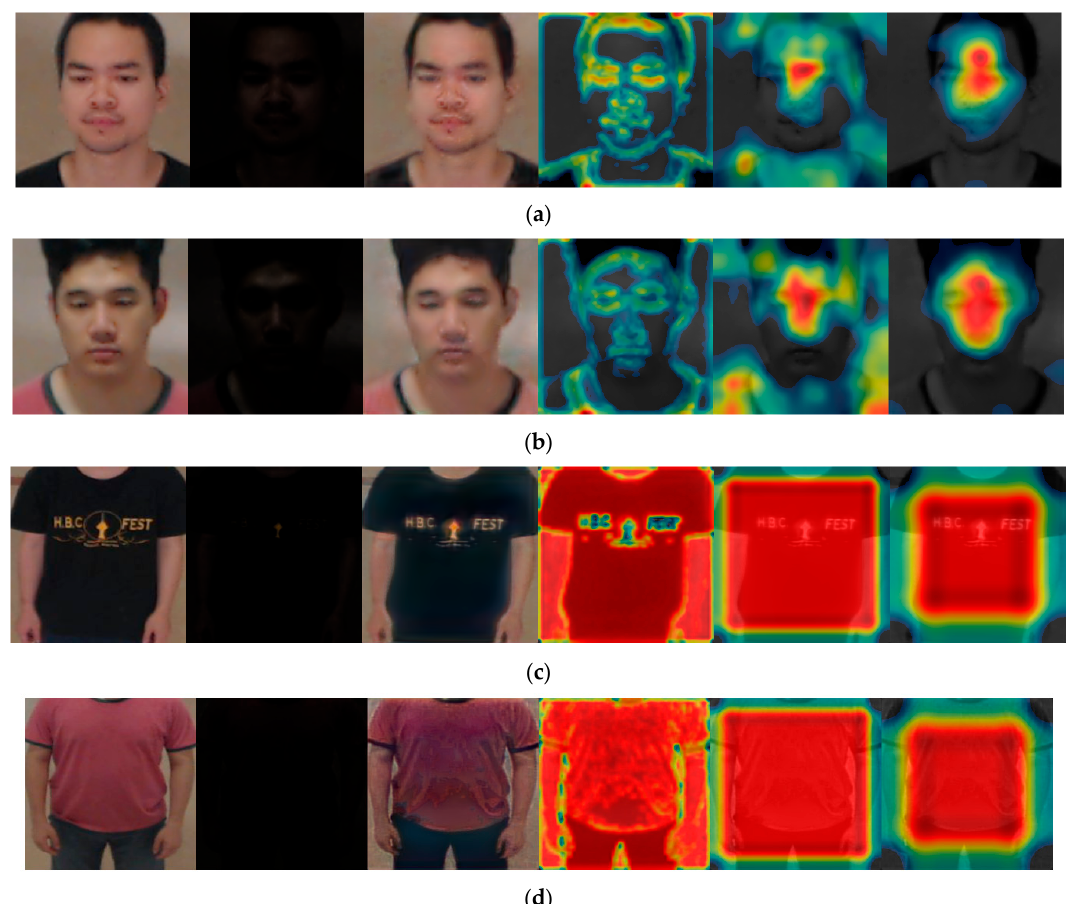
Figure 14. Results on class activation feature map of DFB-DB3. ( a , b ) are the activation map results from face images. From the left image to the right image: original image, low-illumination image, enhancement image from modified EnlightenGAN, result from 7th ReLU layer, result from 12th ReLU layer, and result from 13th ReLU layer of VGG face-net 16. ( c , d ) are the activation map results from body images. From the left image to the right image: original image, low-illumination image, enhancement image from modified EnlightenGAN, result from 3rd batch-normalized layer, result from conv5 2nd block, and result from conv5 3rd block of